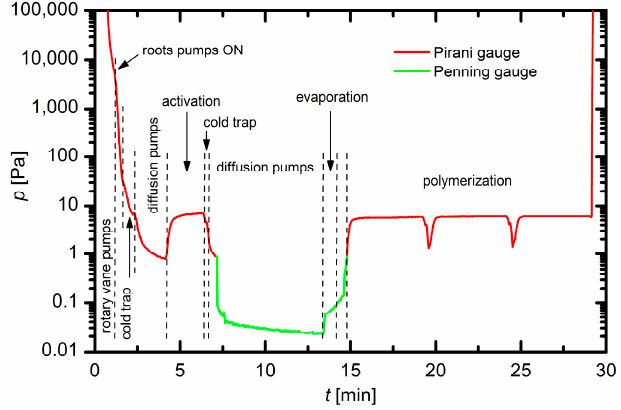
Figure 3. The vacuum levels in the plasma reactor at different stages.